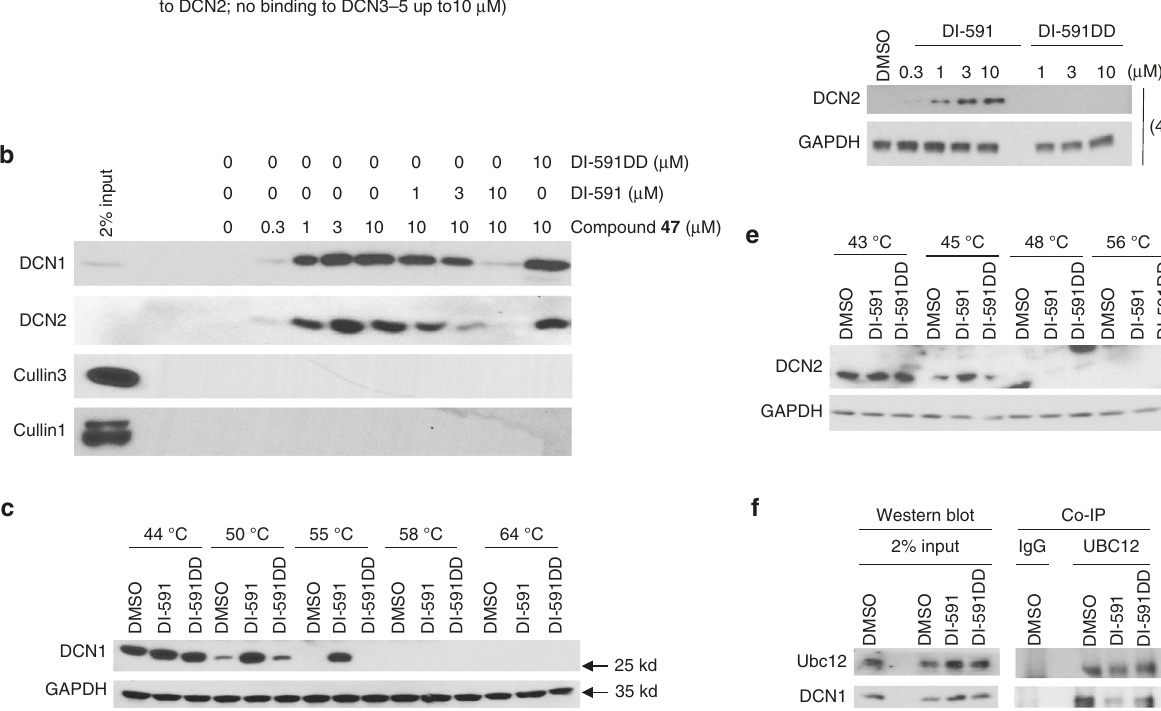
Fig. 4 Cellular engagement of DCN proteins by DI-591. a Chemical structure of biotinylated compound 47 and its binding af fi nities to DCN1-5 proteins. b Pull-down of DCN1 and DCN2 protein by compound 47 and competition by DI-591 in KYSE70 cell lysates. Protein levels of DCN1, DCN2, cullin 1 and cullin 3 pulled down from KYSE70 cell lysates with 47 alone or in combination with DI-591 or DI-591DD were examined by western blotting analysis and speci fi c antibodies. c Enhancement of thermal stability of DCN1 protein by DI-591 but not by DI-591DD in KYSE70 cells. Protein levels of DCN1 in KYSE70 cells treated with DI-591 at 10 µ M, DI-591DD at 10 µ M or DMSO for 1 h, followed by heating at different temperatures for 3 min were examined by western blotting analysis. GAPDH was used as a loading control. d Enhancement of thermal stability of DCN1 and DCN2 proteins by DI-591 but not by DI-591DD treatment in KYSE70 cells. Protein levels of DCN1 and DCN2 in KYSE70 cells treated with DI-591 and DI-591DD at the indicated concentrations for 1 h and then heated at 53 °C (DCN1) and 45 °C (DCN2) for 3 min were analyzed by western blot. GAPDH was used as a loading control. e Enhancement of thermal stability of DCN2 by DI-591 but not DI-591DD in KYSE70 cells. Protein levels of DCN2 in KYSE70 cells treated with DI-591 at 10 µ M or DI-591DD at 10 µ M or DMSO for 1 h, followed by heating at different temperature for 3 min were examined by western blotting analysis. GAPDH was used as a loading control. f Blockage of the association of DCN1 and UBC12 in cells by DI-591 but not by DI-591DD. KYSE70 cells were treated with DI-591 at 10 µ M or DI-591DD at 10 µ M or DMSO for 1 h. The basal protein levels of DCN1 and UBC12 in the cell lysates were examined by western blotting analysis. Protein levels of DCN1 and UBC12 in the cell lysates pulled down by an UBC12 antibody were examined by western blotting